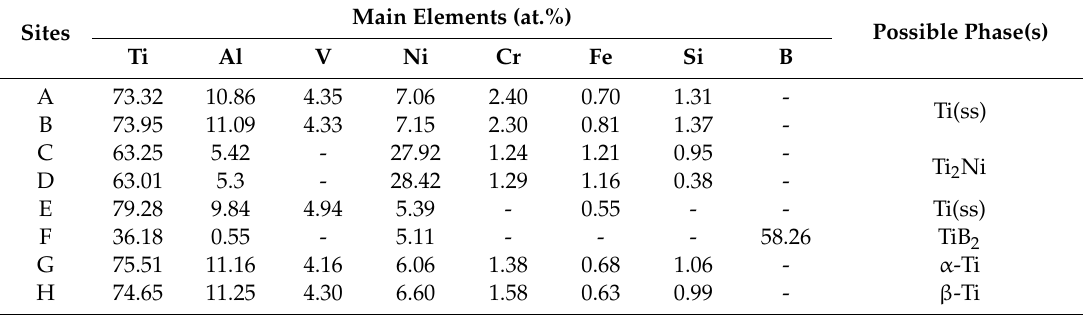
Table 2. EDS analysis associated with Figure